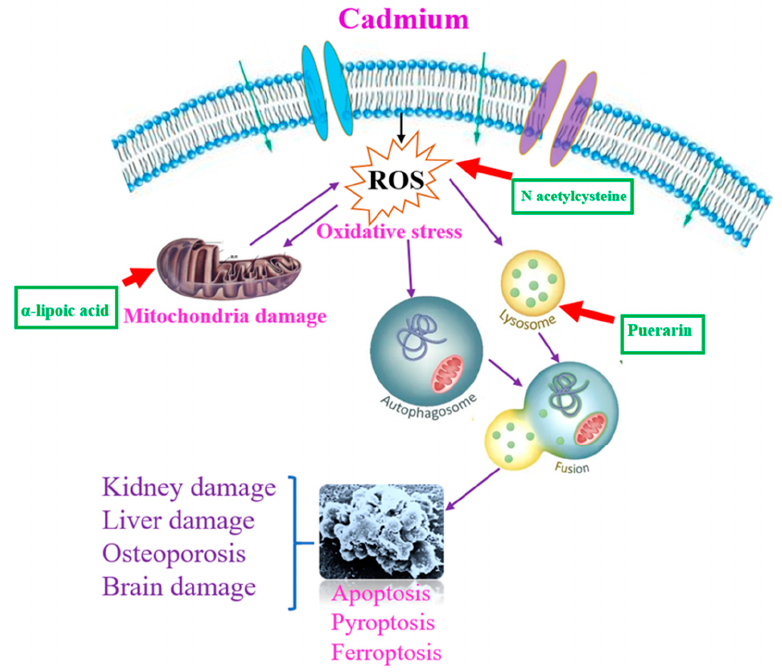
Figure 3. Possible mechanism targets of autophagy-regulated cell death. N-acetylcysteine, puerarin and α -lipoic acid may be an effective protective agent for the prevention and therapy of acute and chronic cadmium-induced neurotoxicity, hepatotoxicity, nephrotoxicity, and bone toxicity.